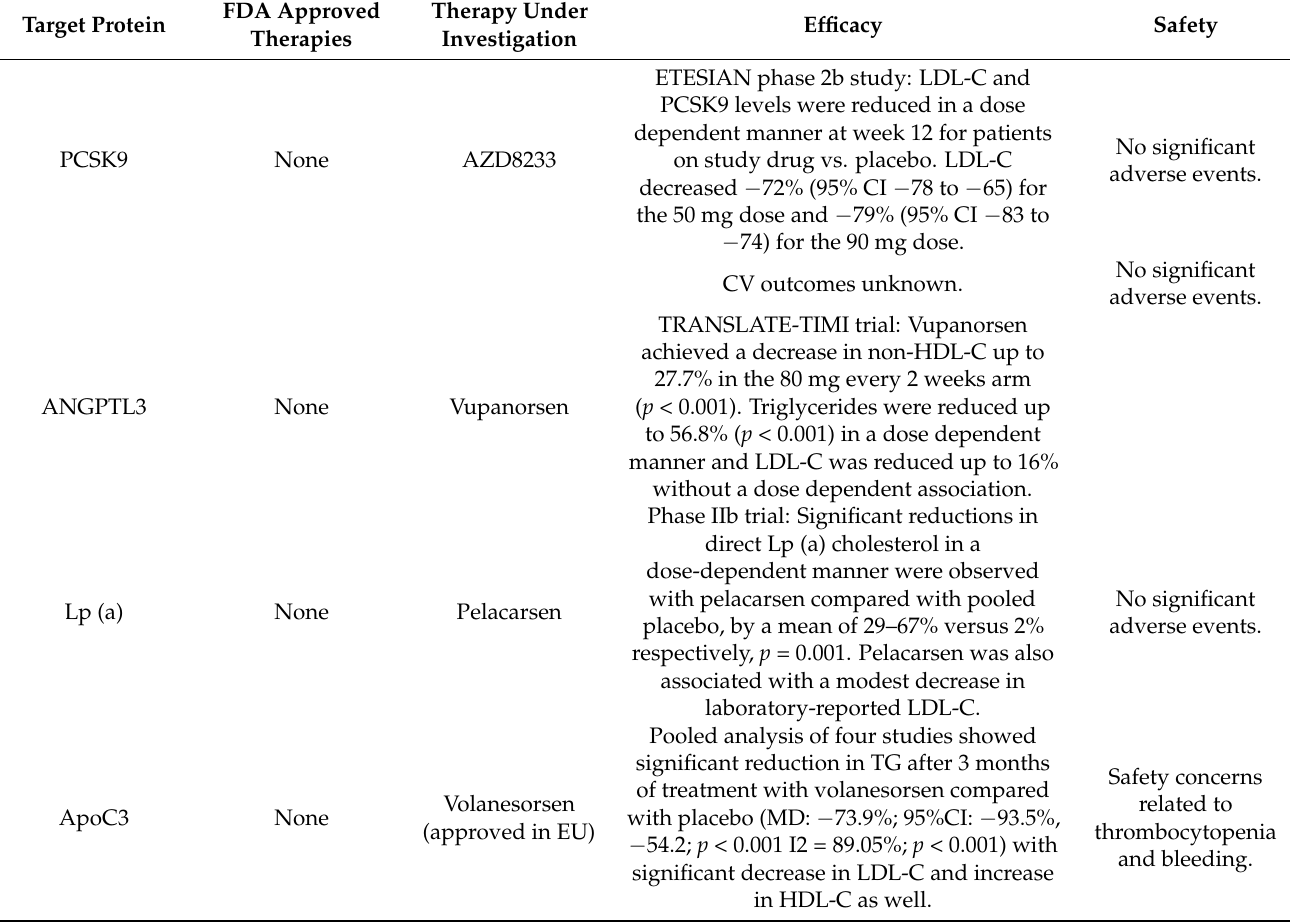
Table 2. Summary of antisense oligonucleotide therapy currently available or under investigation. Target